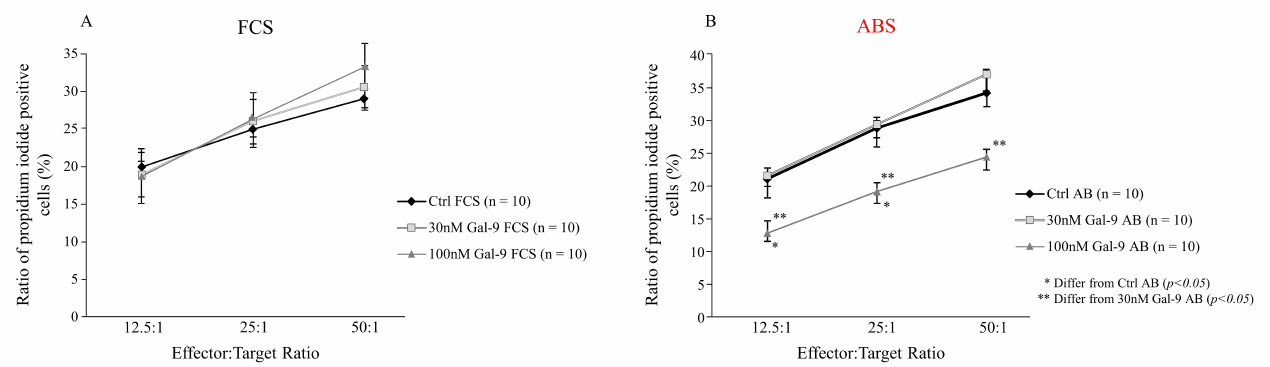
Figure 4. Cytotoxicity of NK-92MI cell line cultured in medium supplemented with FCS or human ABS and after recombi- nant Gal-9 treatment. Cytotoxic activity of NK-92MI cells following 30 and 100 nM Gal-9 addition, cultured in medium supplemented with 10% FCS ( A ) or 10% human ABS ( B ). Cytotoxicity is indicated as a percentage of lysed cells at different effector and target cell ratios. The results are expressed as the mean value ± standard error of the mean (SEM). Differences were considered statistically significant for p -values * < 0.05; ** <